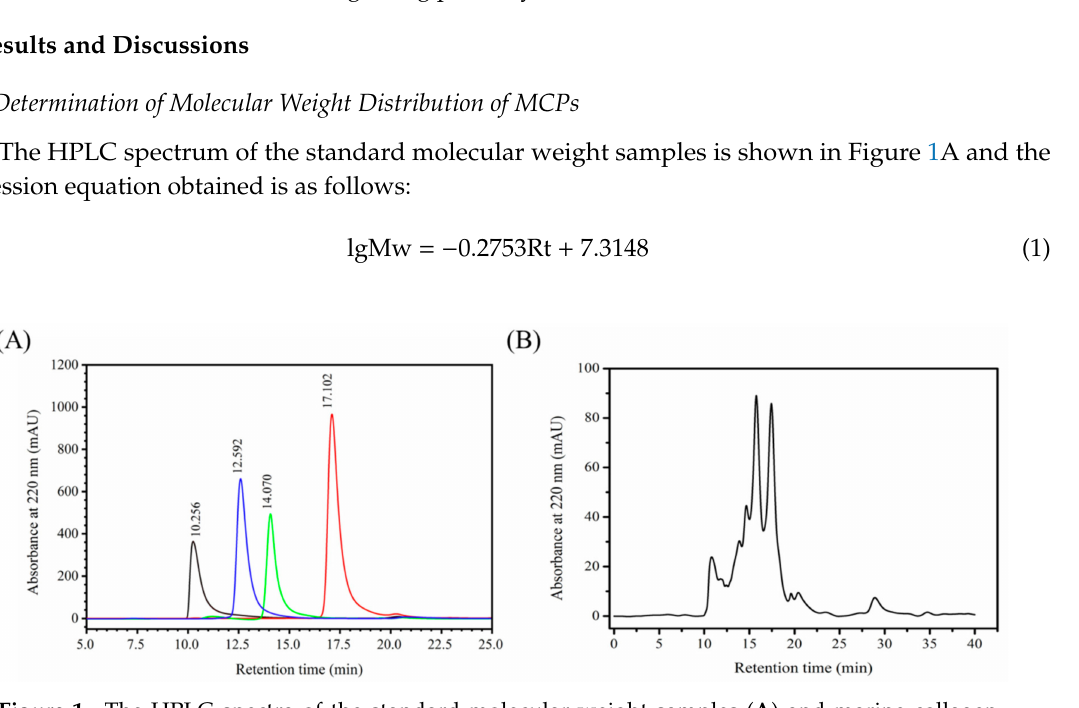
Figure 1. The HPLC spectra of the standard molecular weight samples ( A ) and marine collagen peptides (MCPs) from skin of Nibea japonica ( B